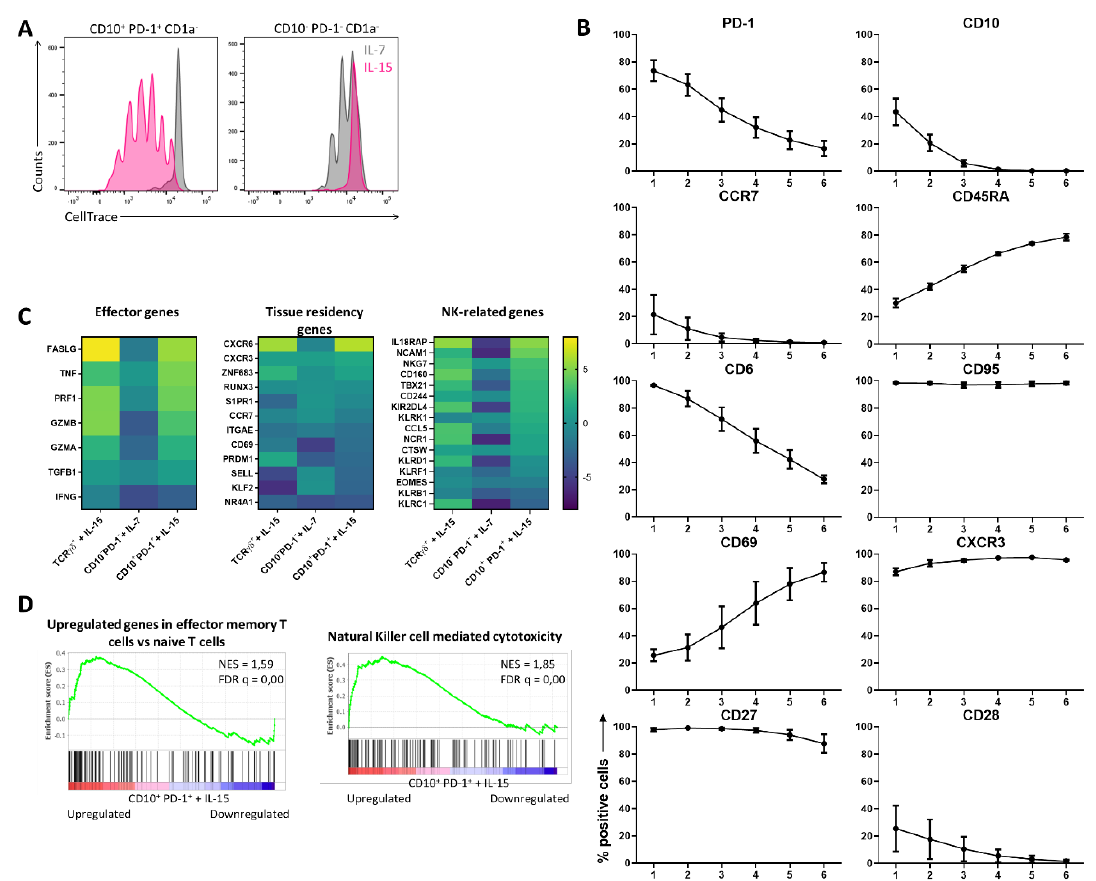
Figure 2. The proliferation of CD10 + PD-1 + IELps with IL-15 induces innate and effector characteristics. ( A ) Proliferation assessed by CellTrace Violet dye dilution in IELps and conventional T cells isolated from the human postnatal thymus, after 5 days of incubation in the presence of IL-7 (10 ng/mL) or IL-15 (10 ng/mL). Representatives of at least five experiments; ( B ) phenotypical changes of the IELps during proliferation with IL-15, measured using flow cytometry and plotted per generation (Figure S2) (mean ± SEM, n = at least 2); ( C ) heatmap for log2 fold change for selected genes, including effector genes, tissue residency genes, and NK-related genes, expressed in TCRγδ + cells incubated with IL-15, conventional T cells with IL-7 and IELps with IL-15 for 11 days, compared to the same population freshly isolated from human postnatal thymus at day 0; ( D ) Gene Set Enrichment Analysis (GSEA) on IELps proliferated with IL-15 compared to freshly sorted IELps cells from human thymus. Left: genes upregulated in effector memory T cells compared to naive T cells as described by Gattinoni et al. [21]. Right: KEGG gene set of genes associated with NK-mediated cytotoxicity (hsa04650). Normalized enrichment score (NES) and false discovery rate q value (FDR q) are shown.